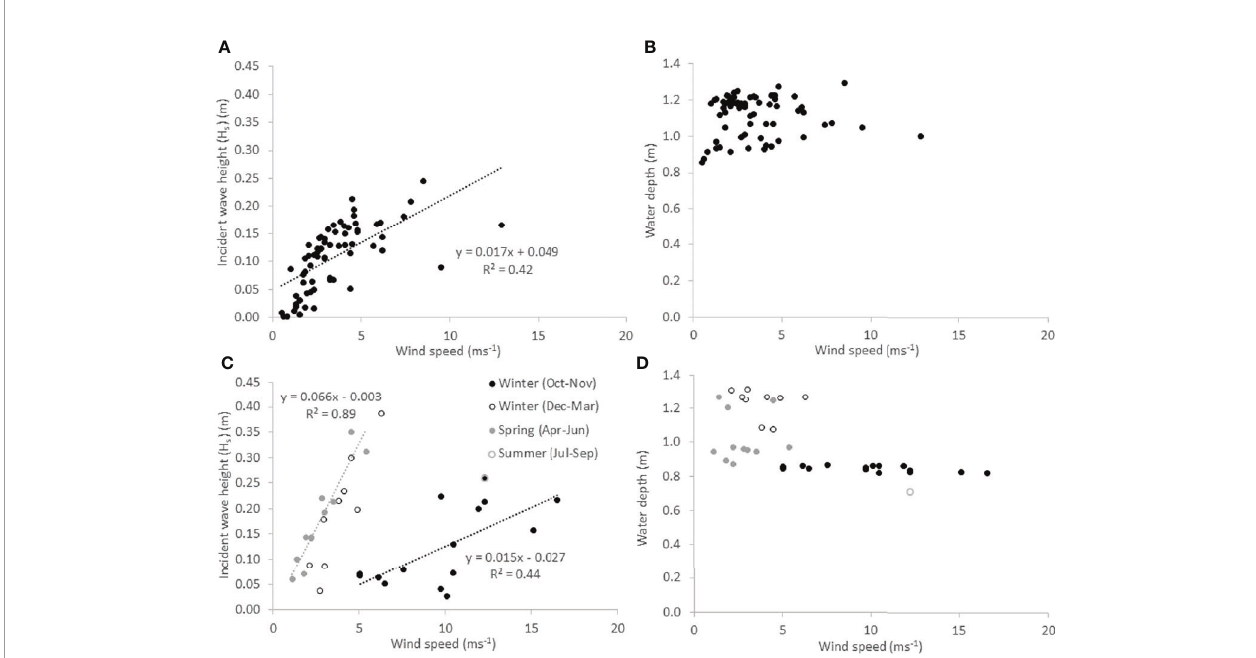
FIGURE 4 | Incident wave height and water depth conditions accompanying different wind speeds during wave recording events at Histria (A, B) and Cape Dolosman (C, D) . Regression lines and equations are shown for all data at Histria (A) and winter conditions only at Cape Dolosman (C) , where data are shown for different